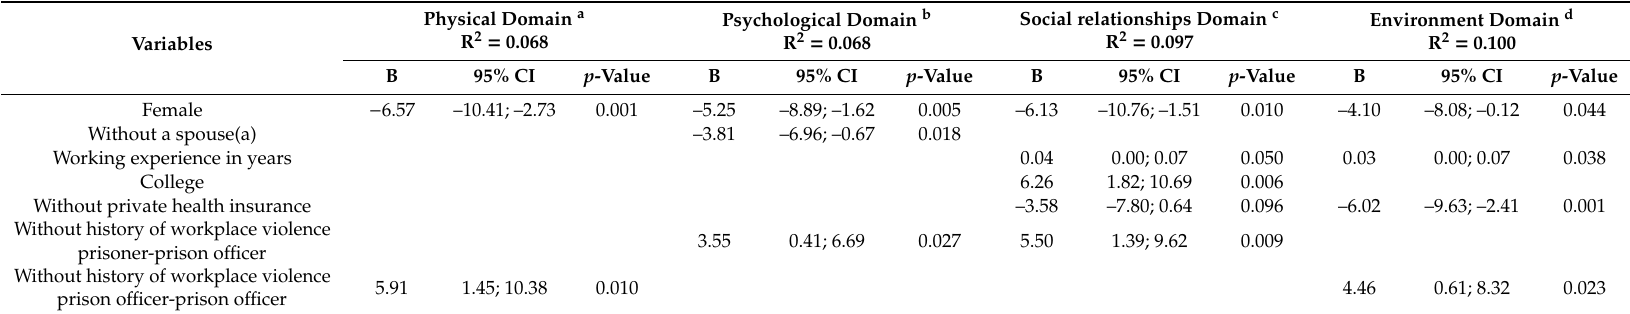
Table 5. Factors associated with the World Health Organization Quality of Life abbreviated version (WHOQOL-BREF) domains of prison o ffi